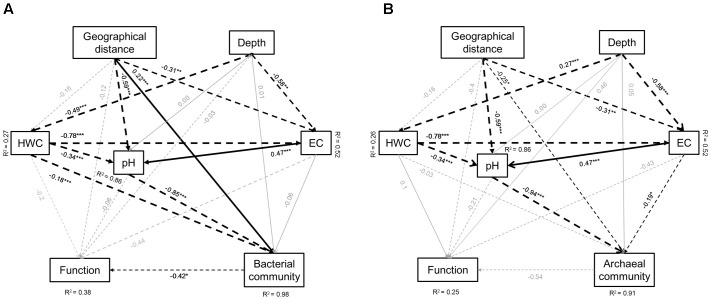
Effects of soil type (geographic distance), depth, soil HWC, pH and salinity (EC) on bacterial community and functional (A) and archaeal community and functional (B) structure. Geographical distance includes longitude and latitude of the soil sampling sites. Solid lines denote positive effects, and broken lines denote negative effects. Thickness of the arrows denotes significance and strength of the influence. R2 represent percentage of explanation of the models on the chosen factors. Significant level: ∗P < 0.05, ∗∗P < 0.01, ∗∗∗P < 0.001. Goodness-of-fit statistics are as following: (A) Chi-square = 0.000, degrees of freedom = 1, RMSEA = 0.000, AIC = 54, GFI = 1.000; (B) Chi-square = 0.000, degrees of freedom = 1, RMSEA = 0.000, AIC = 54, GFI = 1.000.